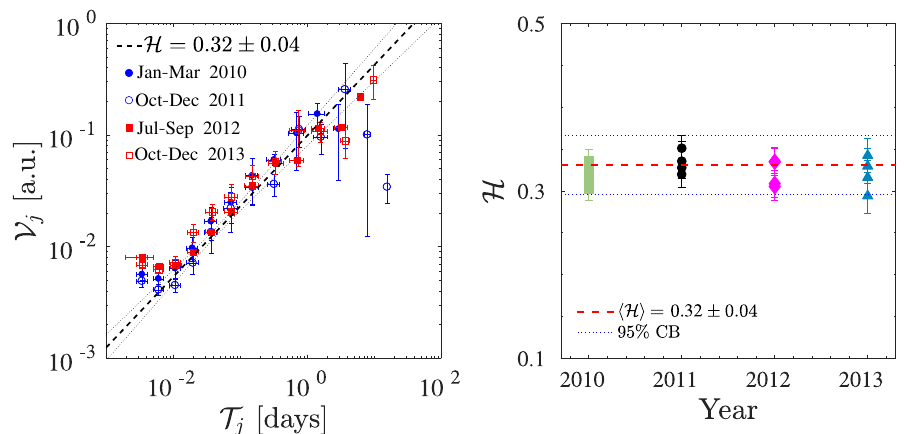
Figure 6. Left panel : IMF variance V j as a function of the average period T j (symbols) for four different samples: January–March 2010, October–December 2011, July–September 2012, and October–December 2013, respectively. The dashed line represents the averaged relation (5), with the associated 95% confidence bounds ( dotted lines ). The scaling holds over a range of periods T ∈ [ 0.02,1 ] days, in accordance with previous estimates. Right panel : H exponent for all samples for j the years 2010 → 2013 (symbols). The horizontal dashed line represents the average value with the associated 95% confidence bounds ( dotted lines